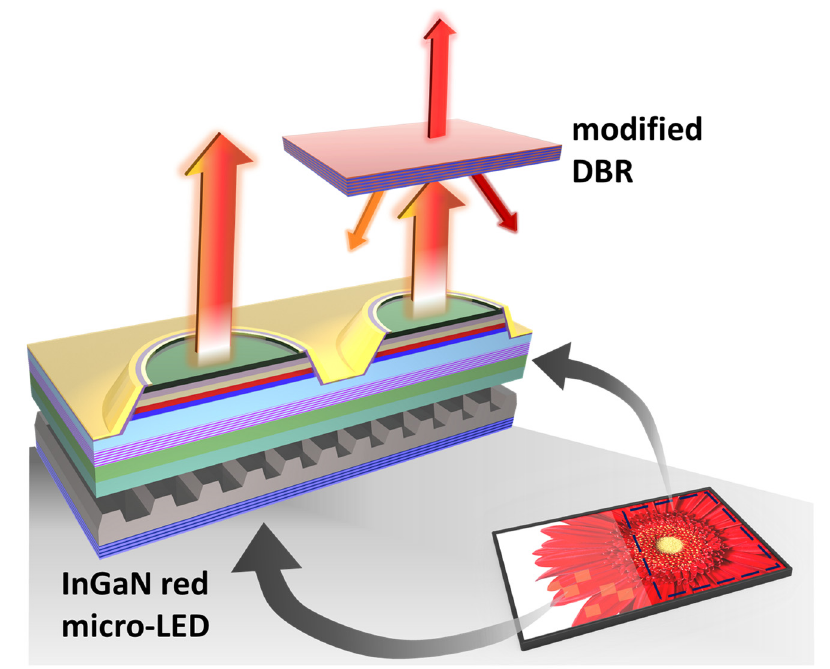
Figure 2. The illustration of the modified distributed Bragg reflector for color stability in InGaN red micro-LED.